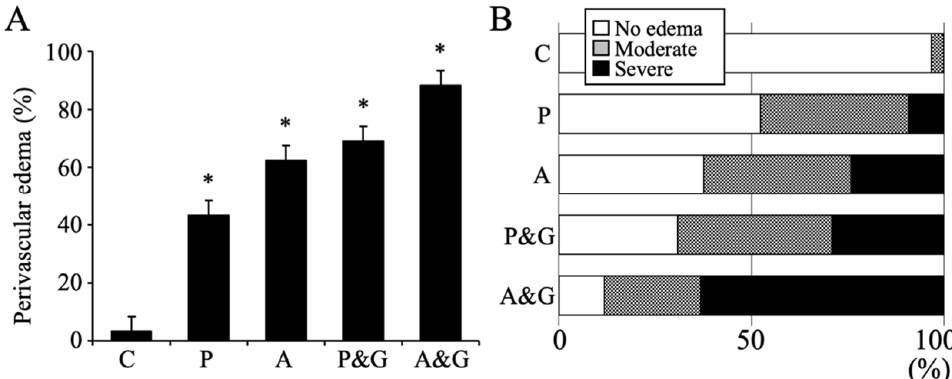
Figure 2. ( A ) shows the percentage of the perivascular edema in hippocampus (total of 40 blood vessels from both sides of hippocampus of each animal, 3 animals/group). Data are expressed as mean ± standard deviation. C, P, A, P&G, and A&G represent the vehicle-treated control animals, piracetam-treated animals, aniracetam-treated animals, piracetam and α -GPC-treated animals, and aniracetam and α -GPC-treated animals, respectively. *: p < 0.05 compared with the control. ( B ) shows the percentage of the degree of perivascular edema in hippocampus (total 40 blood vessels of each animal, 3 animals/group). The criteria for classification of the degree are white bars: no perivascular edema, gray bars: moderate perivascular edema (width of blood vessel > perivascular space), and black bars: severe perivascular edema (width of blood vessel < perivascular space).